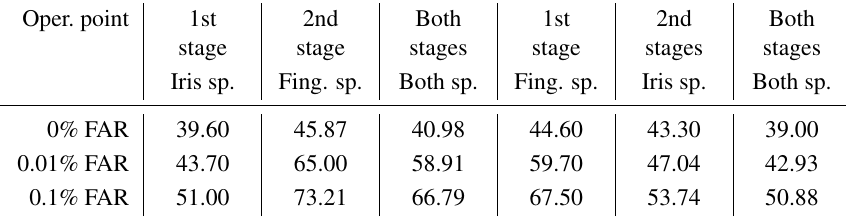
Table 2. FAR (%) of the iris–fingerprint system in parallel fusion mode, with the sum, weighted sum, and LLR rules (top), and iris–fingerprint and fingerprint–iris systems in serial fusion mode (bottom), when either the iris, the fingerprint or both the iris and fingerprint are spoofed, at three operating points.